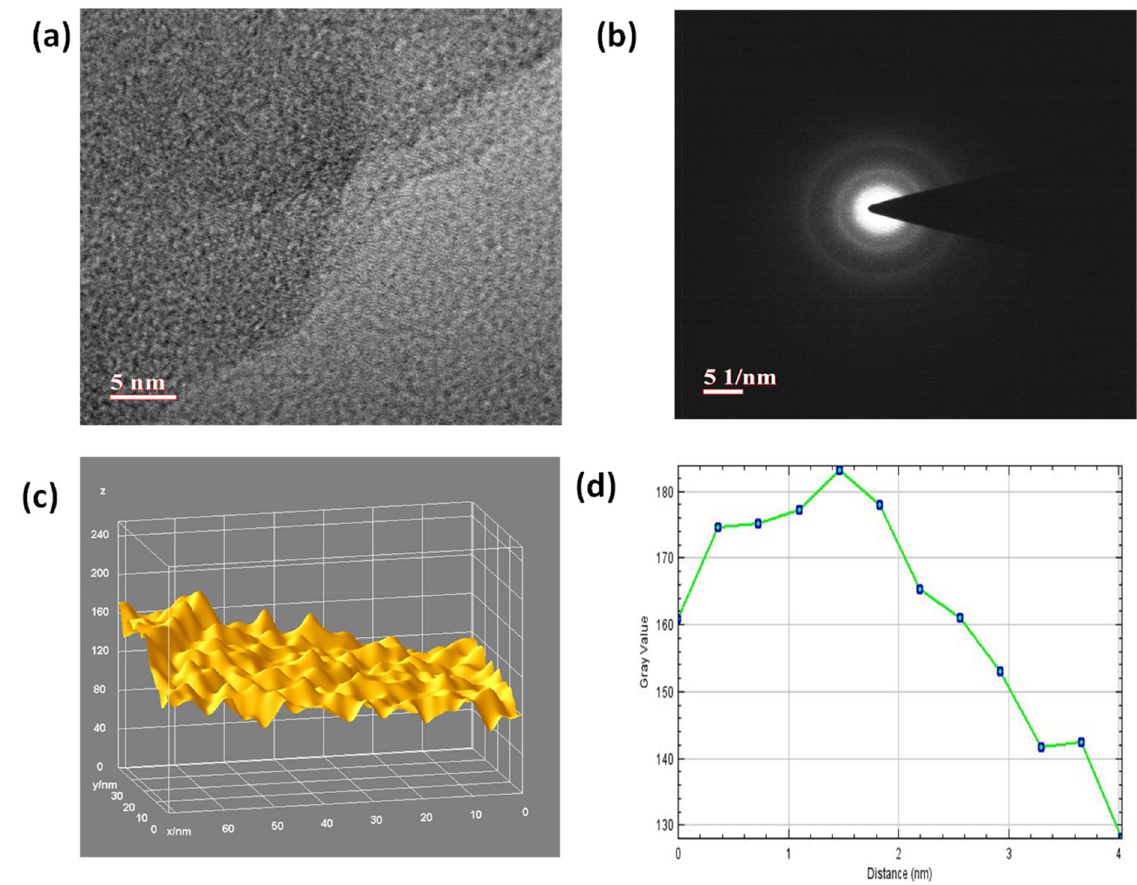
Figure 6. ( a ) HRTEM images of GNs at the magnification of 5 nm, ( b ) SAED pattern for GNs, ( c ) 3D surface plot of HRTEM image of GNs; ( d ) Plot profile diagram for showing the average number sheets present within